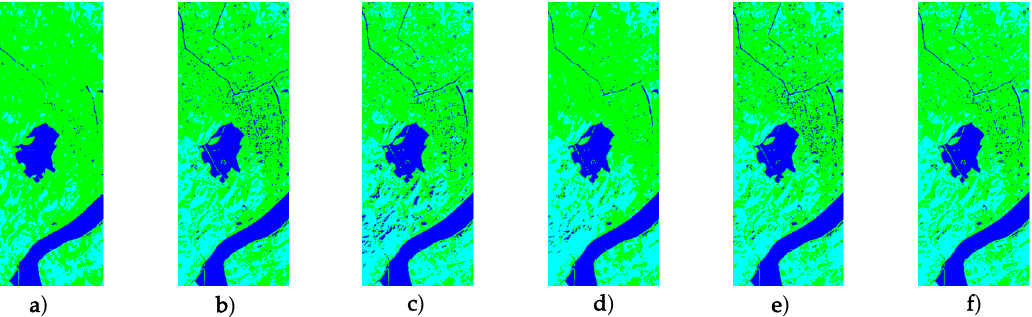
Figure 7. The classification maps of different methods on Pavia Center → Pavia University dataset. (a) Yang et al. method. (b) Mei et al. method. (c) Wang et al. +FT method. (d) First-Stage + FT. (e) TDDA method. (f) Original map.